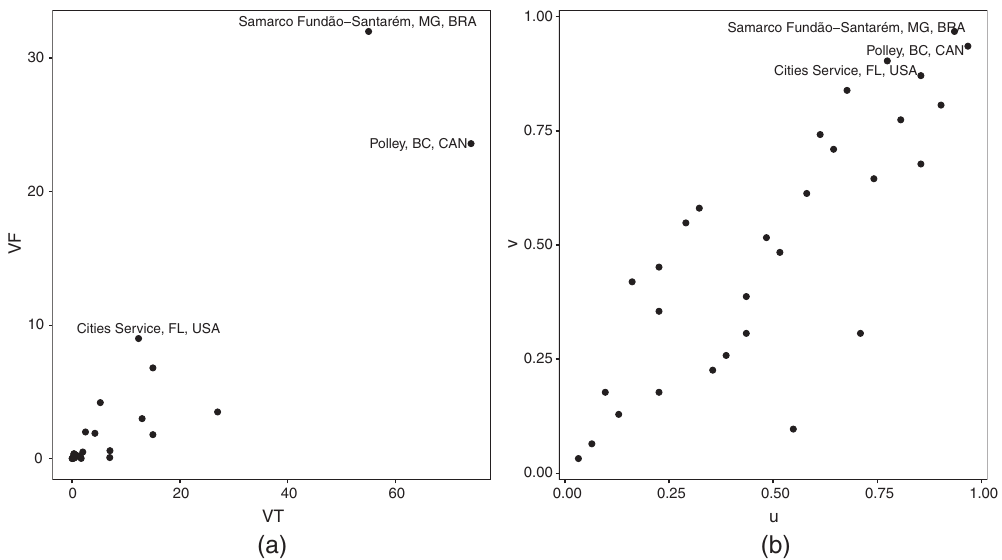
Figure 1. Scatterplot for V T ( (cid:1) 10 6 m 3 ) vs. V F ( (cid:1) 10 6 m 3 ) with (a) original observations and (b) observations transformed to [0, 1] by scaling ranks, U vs. V